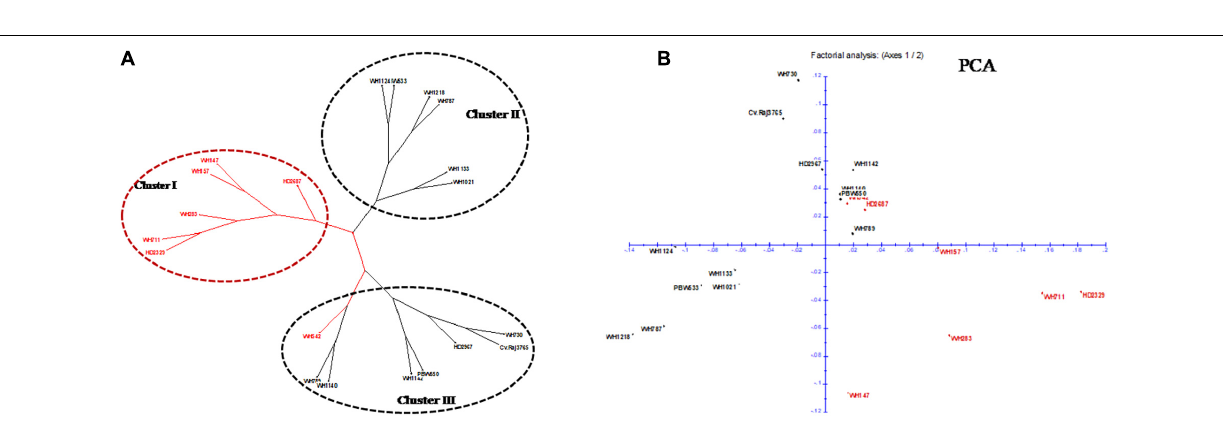
Frontiers in Genetics |